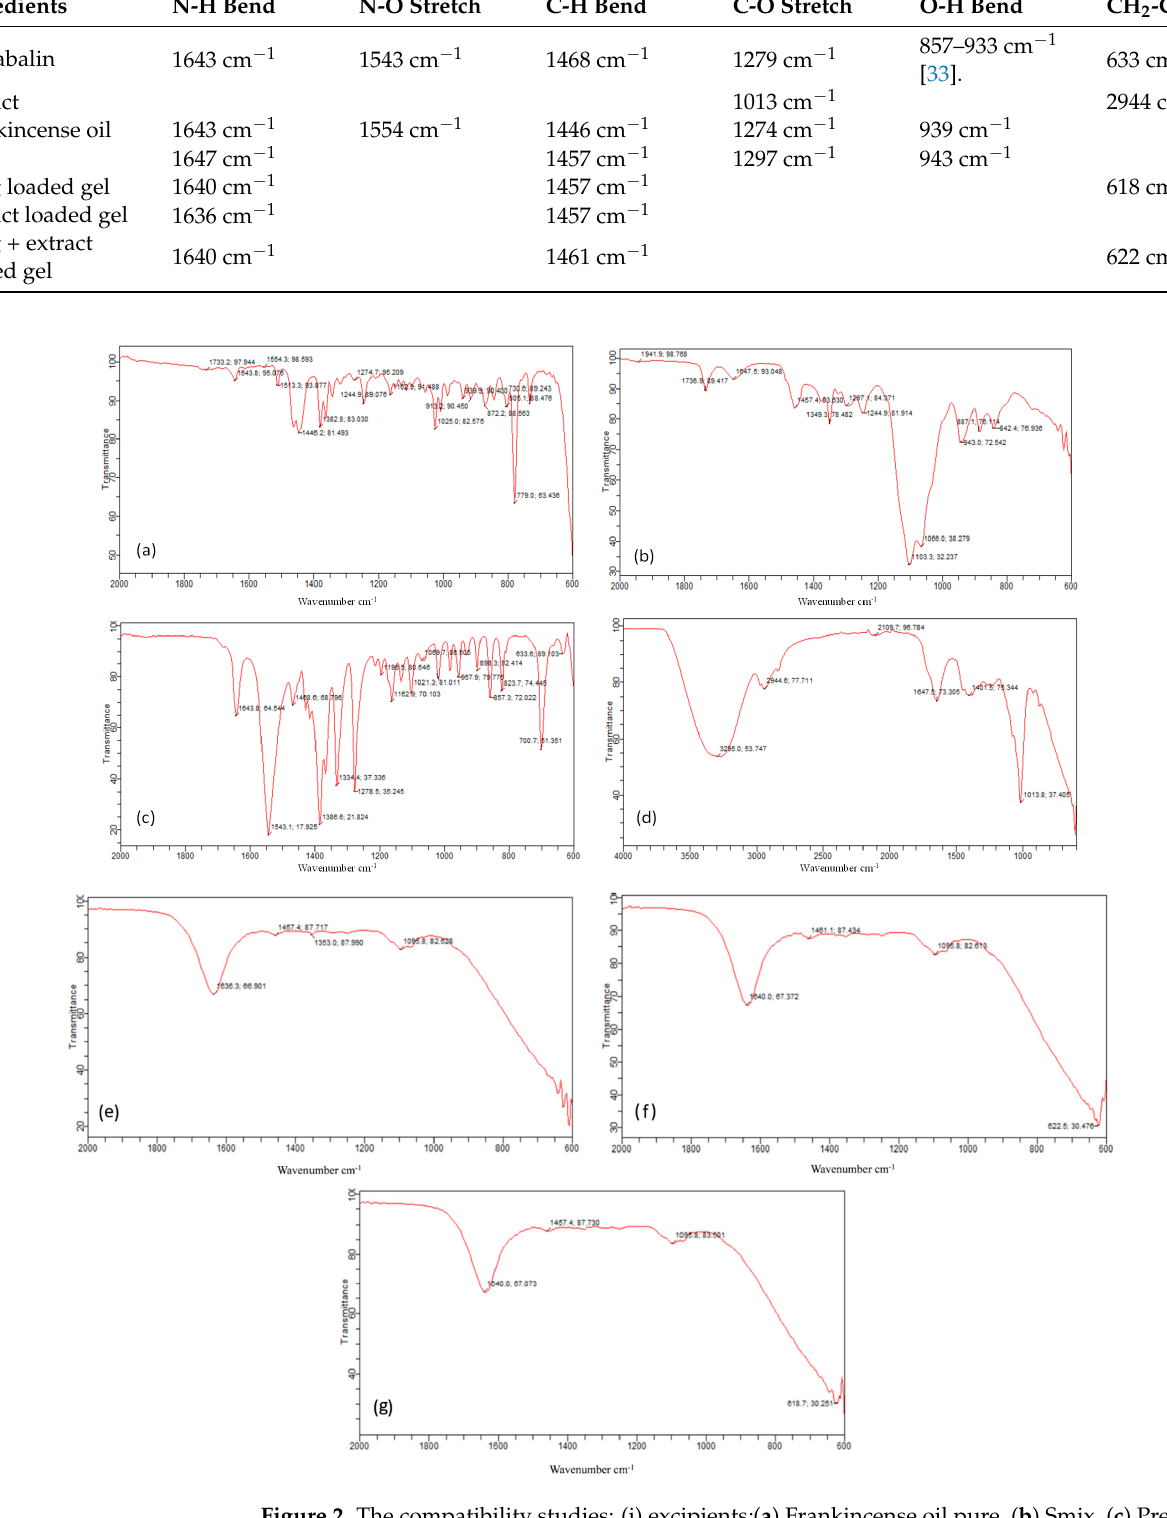
Figure 2. The compatibility studies: (i) excipients;( a ) Frankincense oil pure, ( b ) Smix, ( c ) Pregaba- lin pure, ( d ) Withania coagulans extract pure ((ii) topical gels; ( e ) Extract loaded gel, ( f ) co-combination gel, ( g ) drug loaded gel).